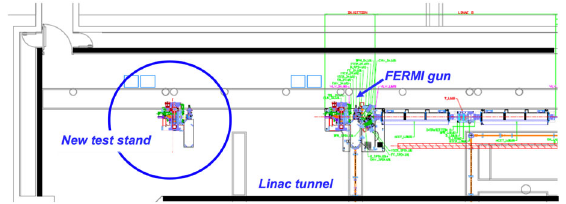
FIG. 3. New test stand in CTF.